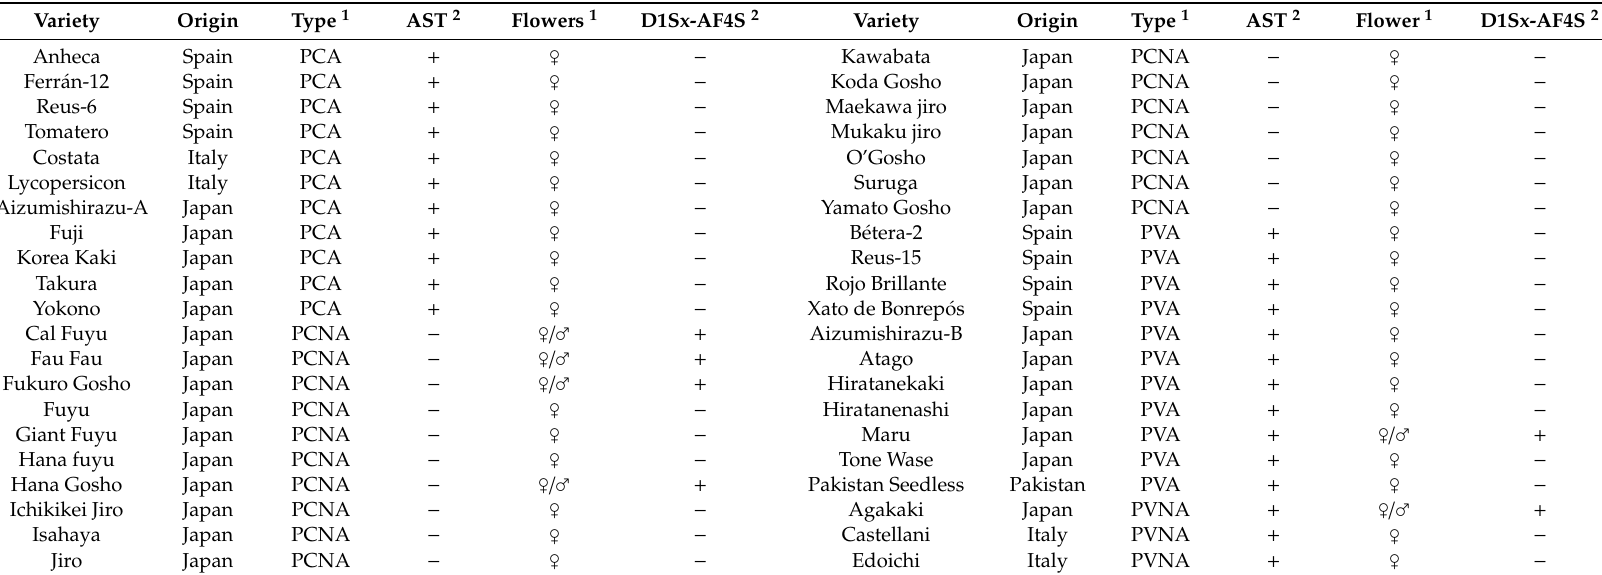
Table 1. Plant material studied, origin, astringency type, genotype of AST marker, flower type and genotype of the DlSx-AF4S marker.